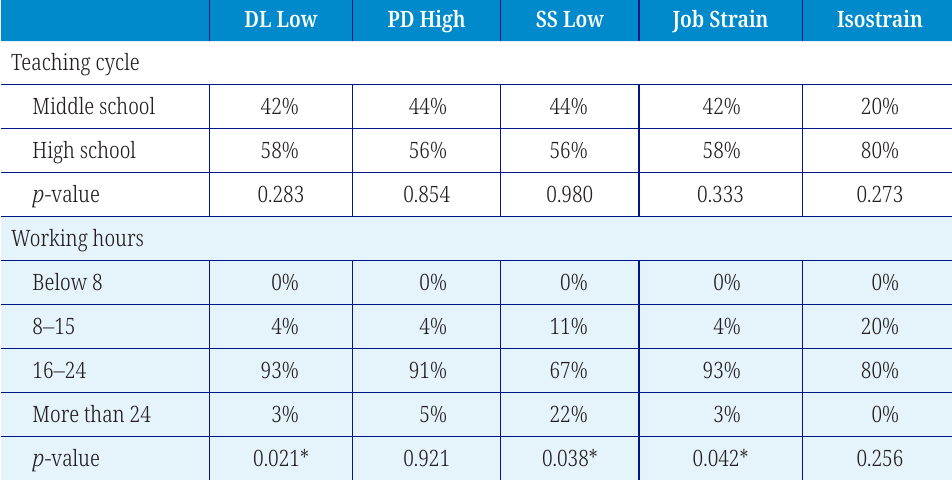
Table 6. Distribution of studied population according to teaching cycle, working hours,